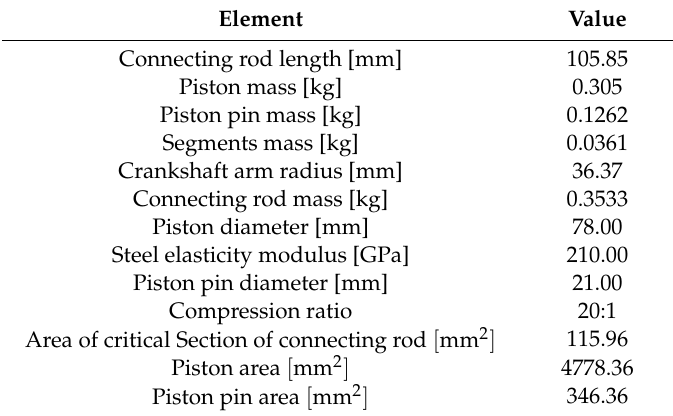
Table 1. Geometric characteristics of the engine SOKAN